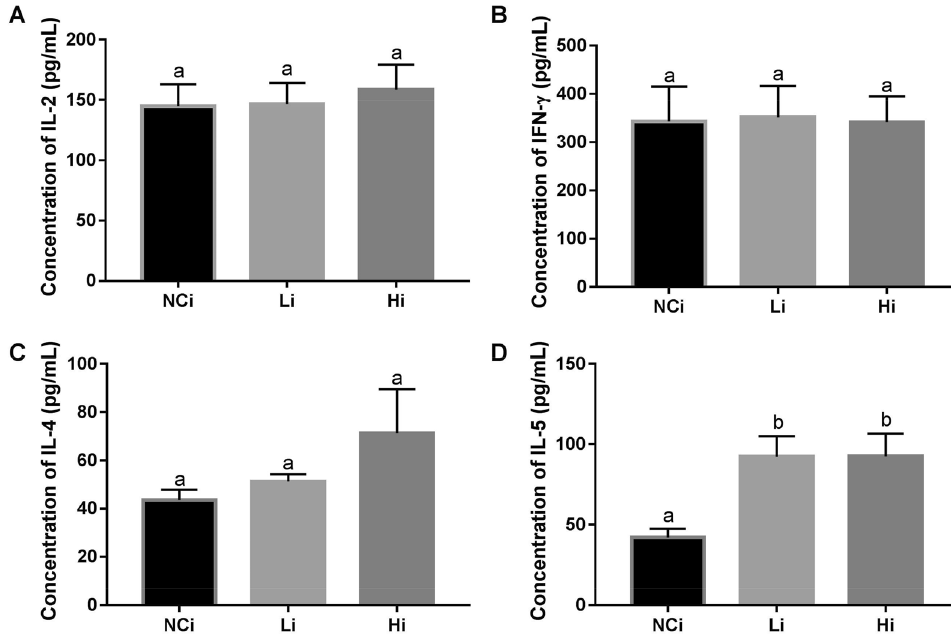
Figure 3. Cytokine profiles of splenocytes from OVA-injected (s.c.) mice ex vivo. Levels of the cytokines ( A ) IL-2, ( B ) IFN-γ, ( C ) IL-4, and ( D ) IL-5 in the supernatant. NCi mice gavaged with saline, negative control,